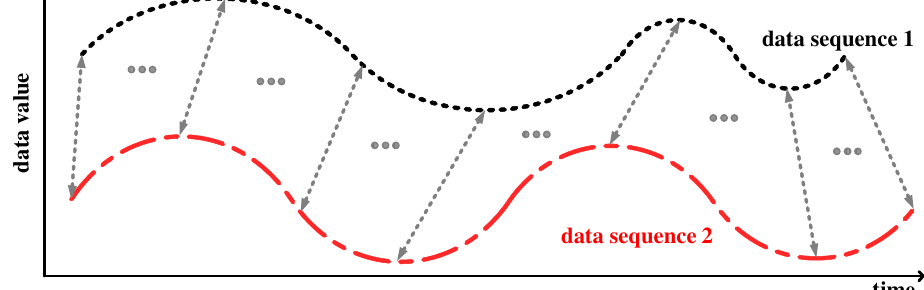
Figure 2. Time alignment of two data sequences; the aligned points are denoted by the